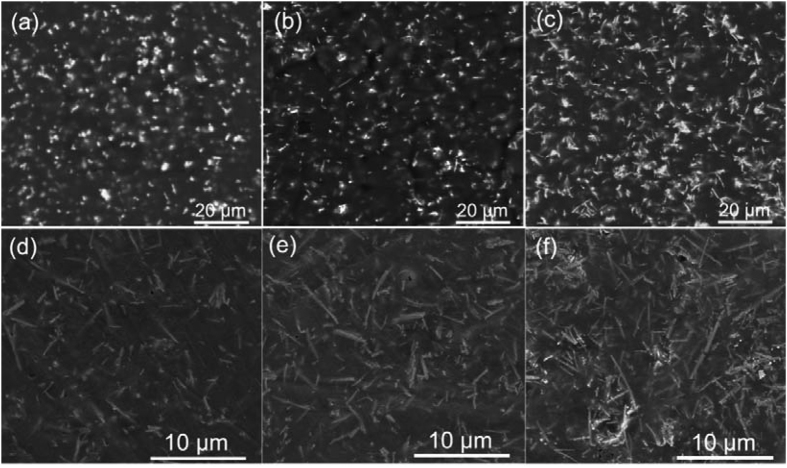
(a–c) SEM images of the nanocomposites with 5 vol% low aspect ratio BaTiO3 NFs synthesized at 210 °C for 2 h, 6 h and 12 h. (d–f) SEM images of the nanocomposites with 2.5 vol%, 5.0 vol% and 7.5 vol% high aspect ratio BaTiO3 NFs synthesized at 210 °C for 12 h.